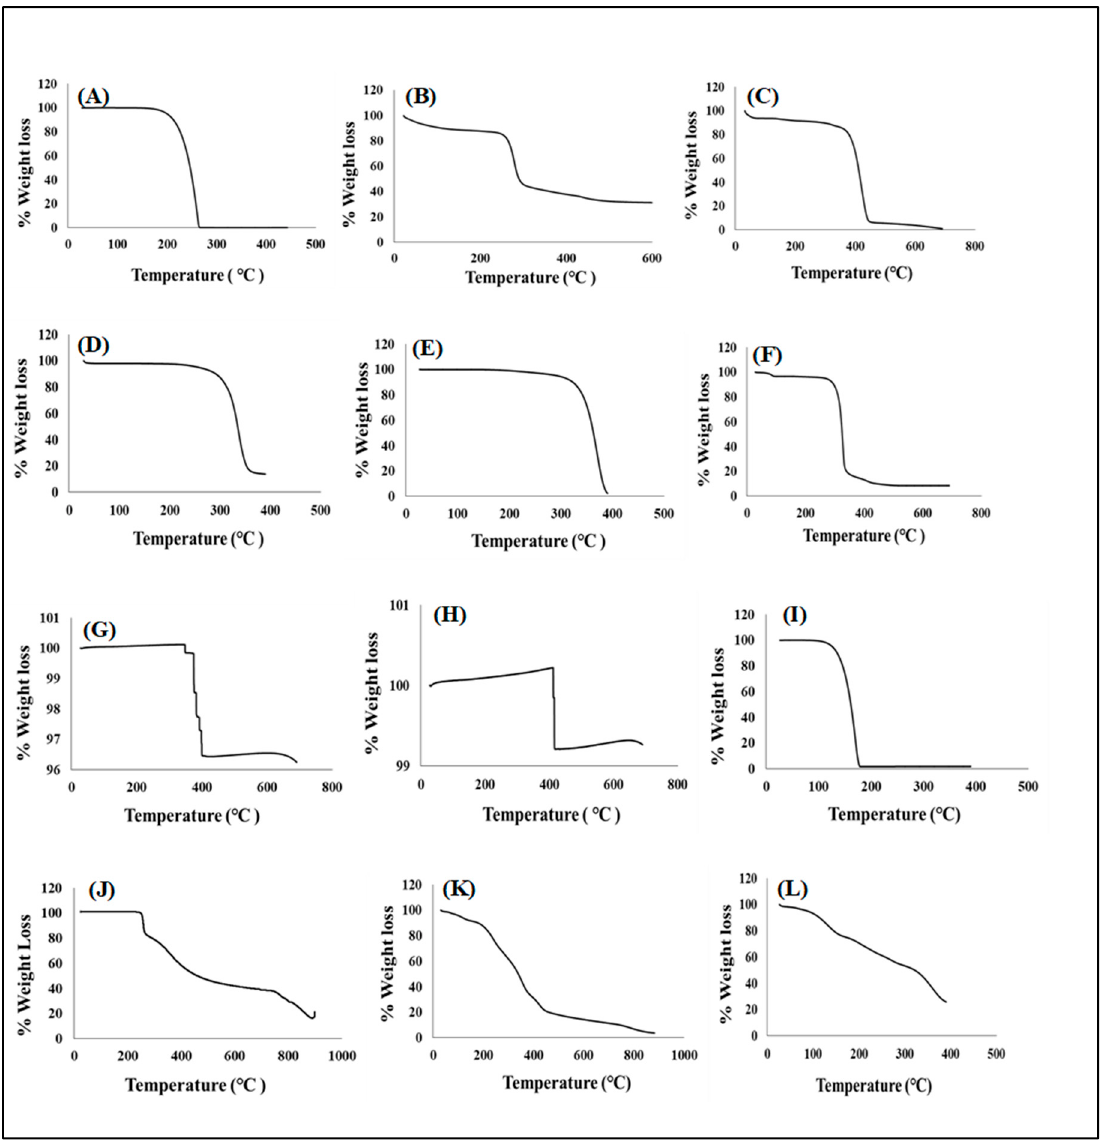
Figure 3. Thermogravimetric (TGA) curves of ( A ) xylitol, ( B ) Primellose ® , ( C ) polyvinylpyrrolidone, ( D ) methylcellulose, ( E ) Kolliphor ® , ( F ) magnesium stearate, ( G ) potassium chloride, ( H ) sodium chloride, ( I ) pyrazinamide, ( J ) rifampicin, ( K ) placebo and ( L ) the drug-loaded formulation.